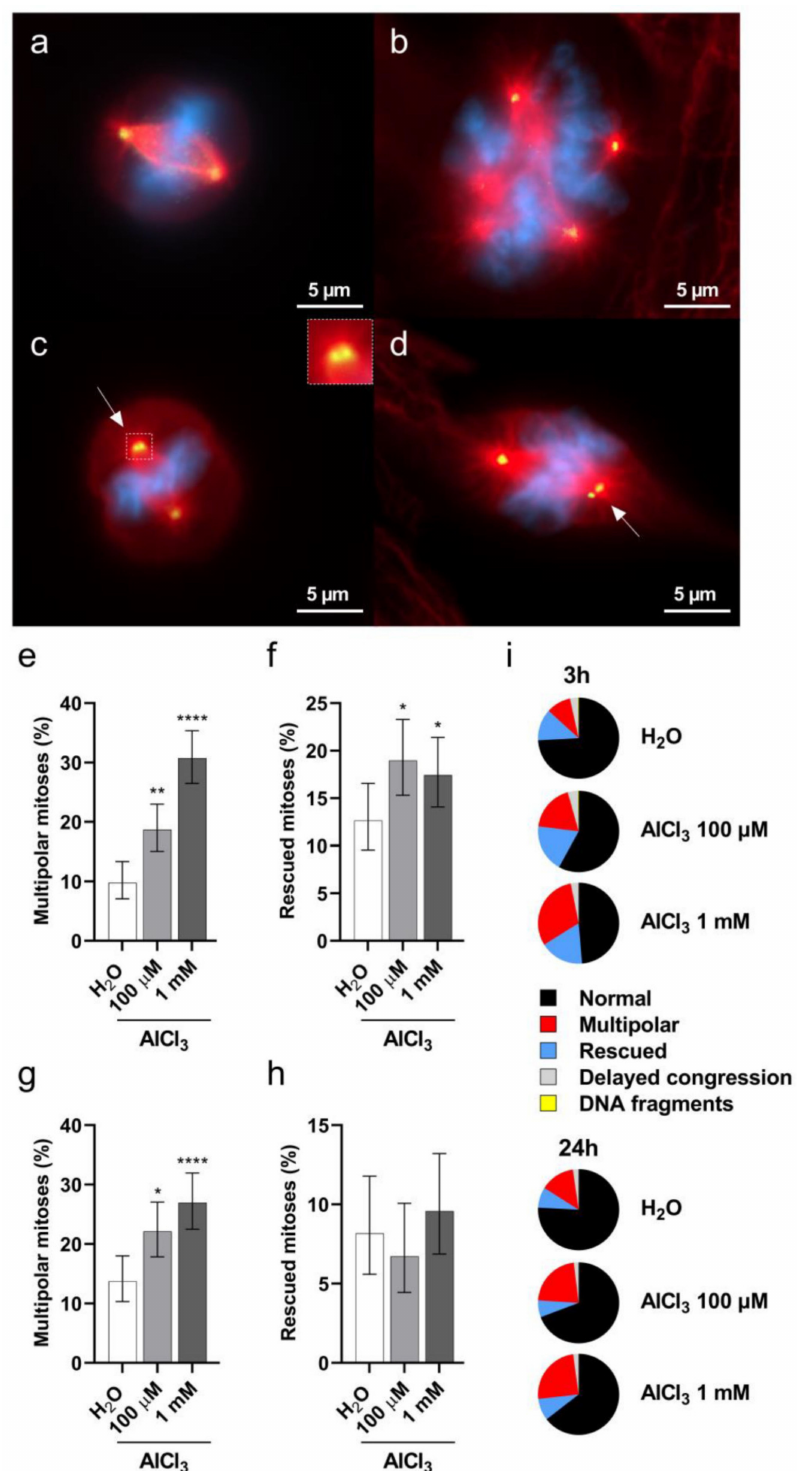
Figure 6. Aluminum induces mitotic spindle abnormalities in V79 cells. The cells were exposed for 3 h to 100 µ M or 1 mM AlCl 3 or an equivalent volume of H 2 O vehicle control. After 17 h of recovery in normal culture medium (in the absence of AlCl 3 ) the cells were fixed and stained for DNA with DAPI (blue), for centrosomes with gamma-tubulin (green), and for microtubules with alpha-tubulin (red). ( a ) Representative image of a normal bipolar H 2 O-treated cell at the metaphase stage of cell division. ( b ) Representative image of a multipolar 1 mM AlCl 3 -treated cell at the metaphase stage of cell division. ( c , d ) Representative images of rescued 1 mM AlCl 3 -treated cells at the metaphase